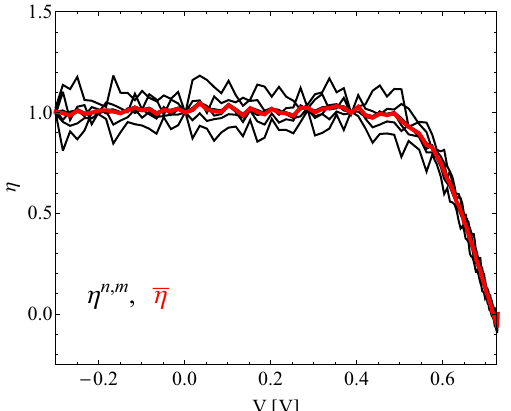
Fig. 2. All possible collection efficiencies (black) and the mean collection efficiency (red) of the sample being extracted from four different illuminated curves.